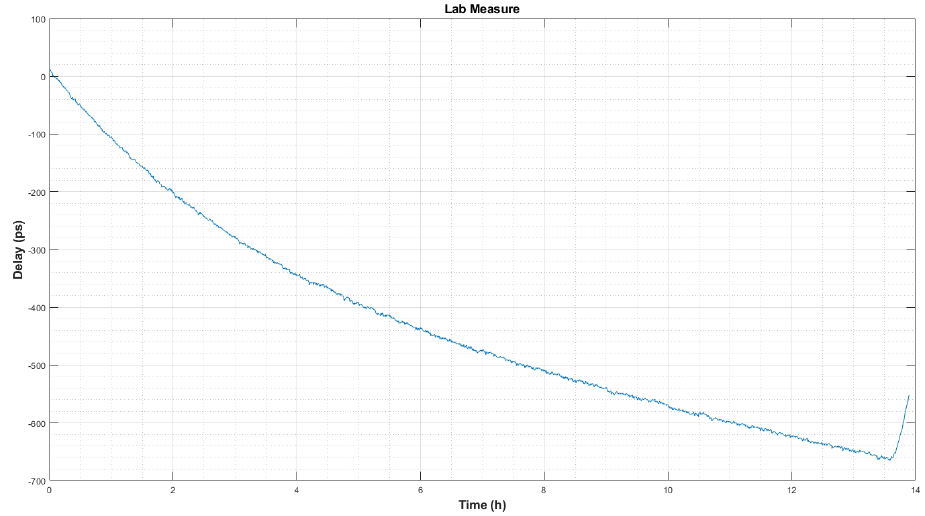
Figure 10. Delay measurement in the laboratory. The slope is due to thermal drift caused by ambient temperature.